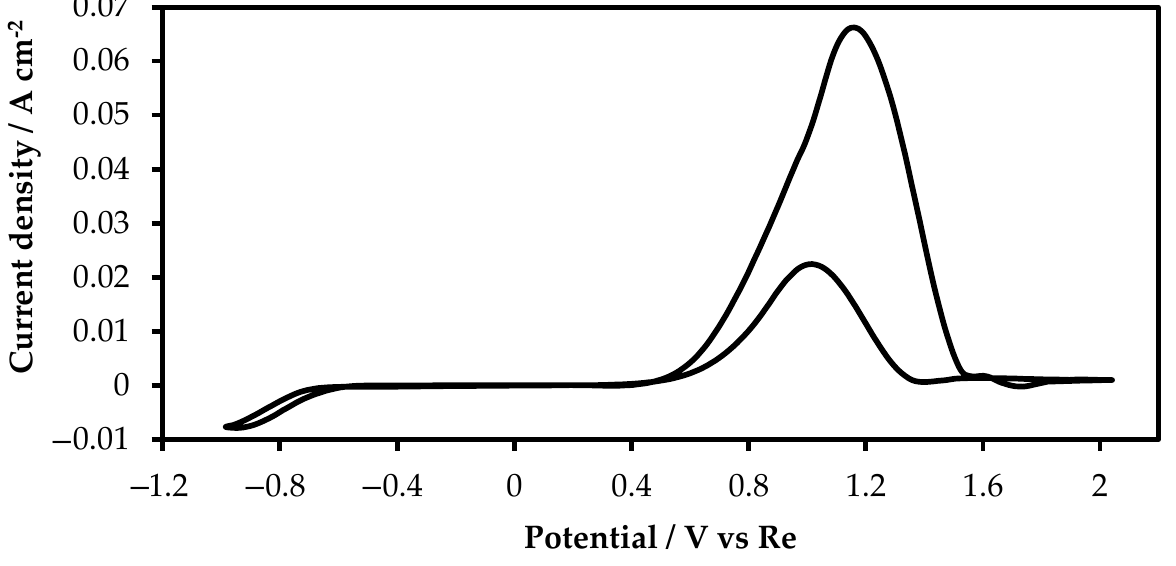
Figure 2. Electrochemical window of molten KF-KBF 4 -B 2 O 3 on a glassy carbon wire electrode; Scan rate: 250 mV/s; RE:Re; CE:GC.